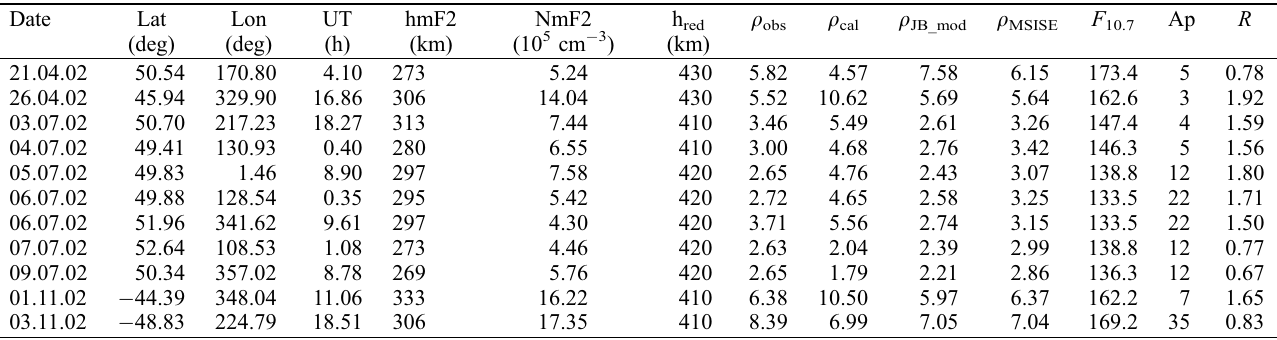
Table A5. Same as Table A2 but for solar maximum